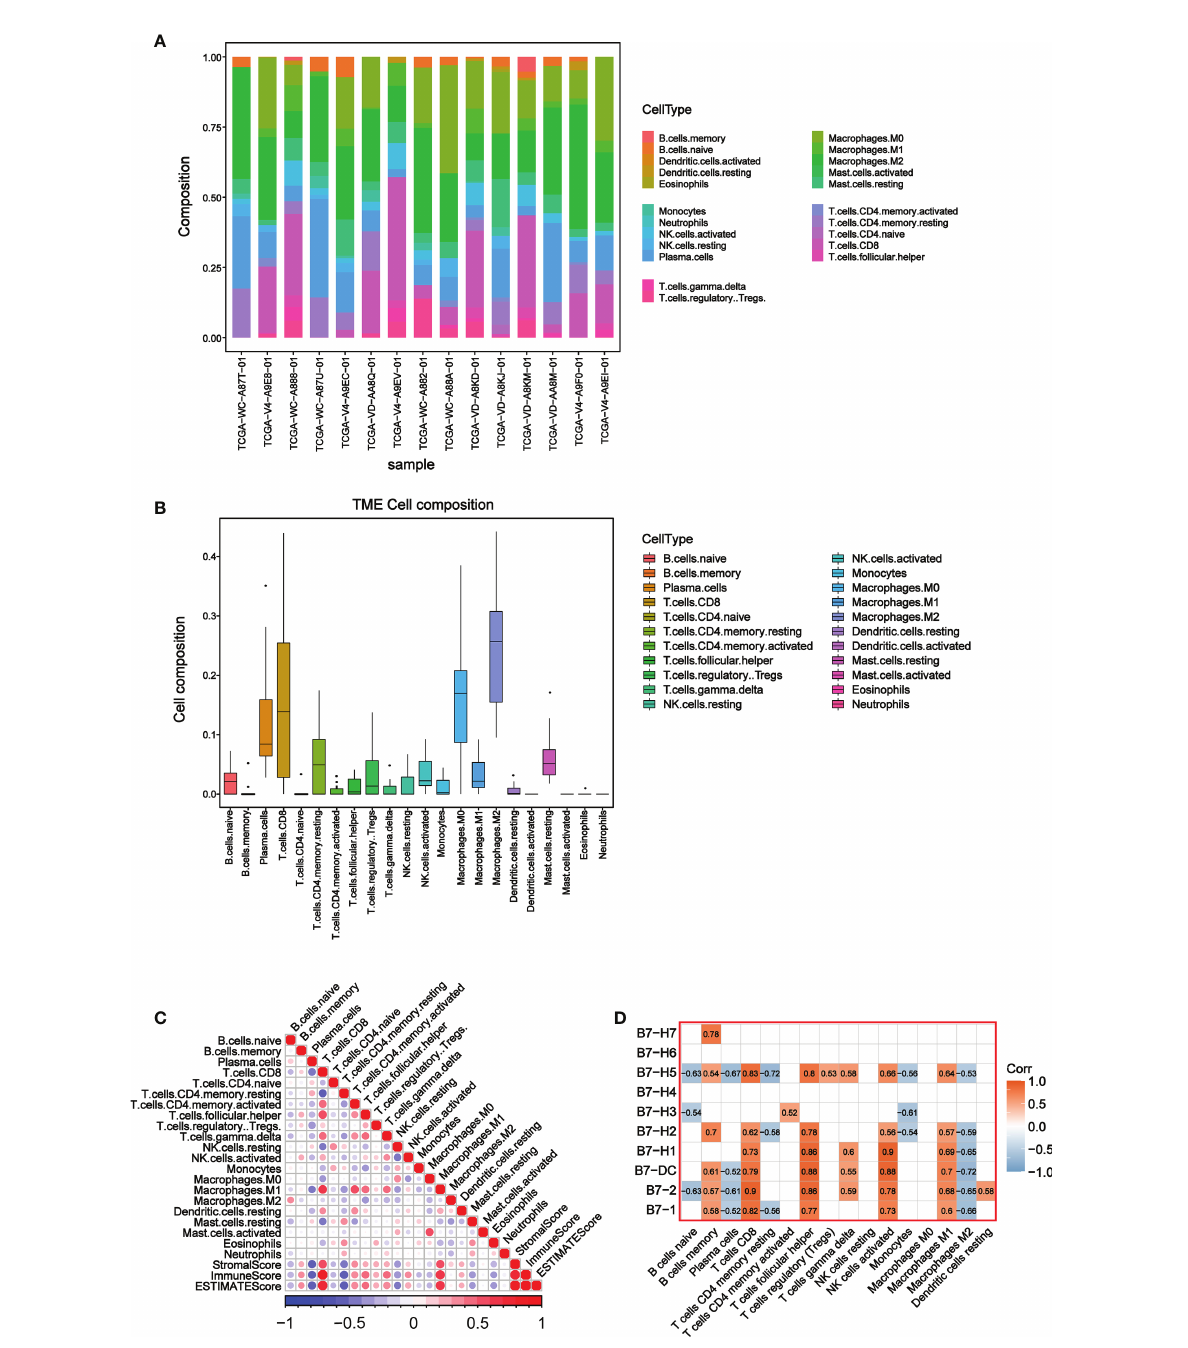
FIGURE 4 Correlation between B7 family and CIBERSORT score. (A) Cell composition in each UVM sample. (B) Composition of 22 immune-related cells in TME. (C) Correlation analysis among 22 immune-related cells, stromal score, immune score and ESTIMATE score. (D) Correlation analysis between 22 immune-related cells and B7